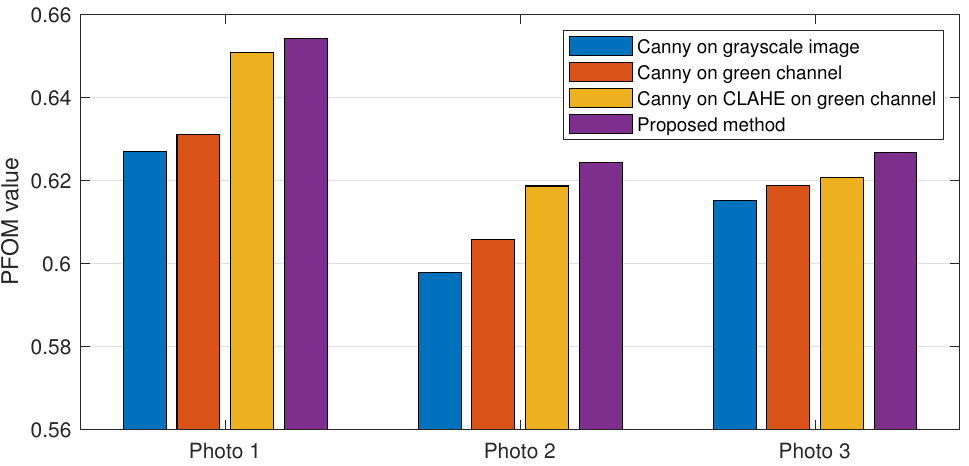
Figure 18. Comparison of PFOM values of photos 1 to 3 from DRIVE dataset with different segmen- tation methods and different processing on input image.